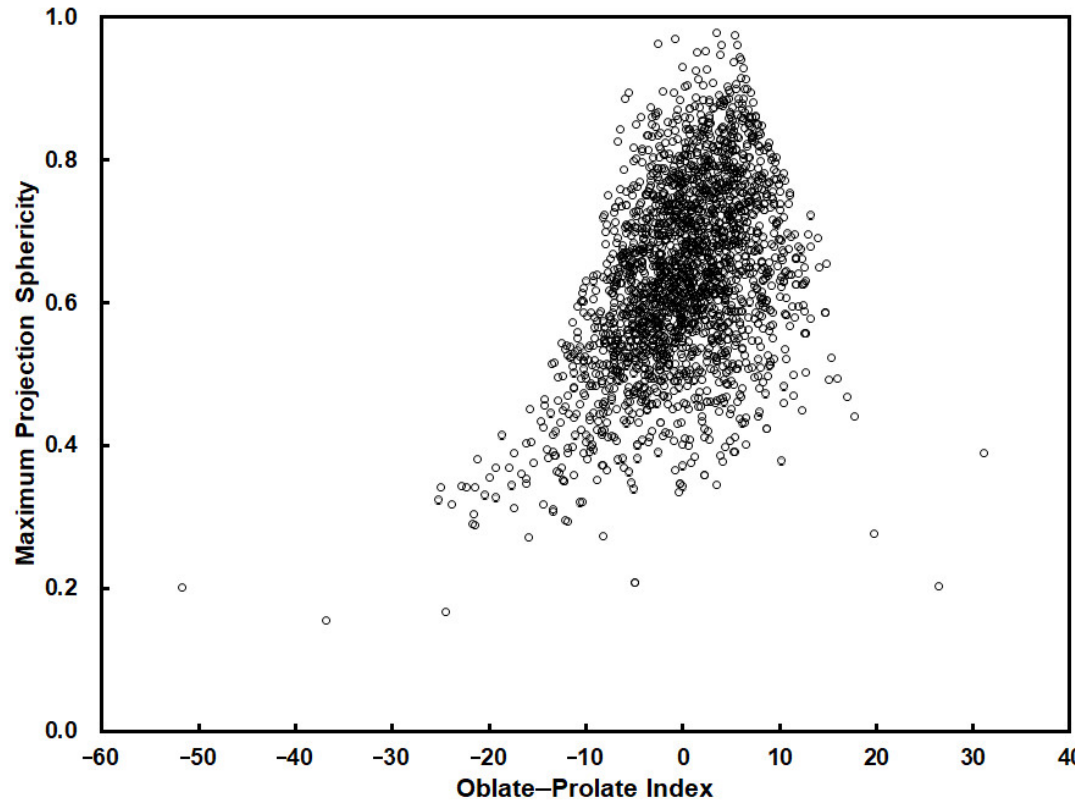
Figure 21. The Oblate–Prolate Index and Maximum Projection Sphericity of 3171 gravels from fluvial, beach, tsunami and weathering environments. Source of data: Gale [95], Jones and Hunter [96], Bryant and Haslett [97], Kennedy et al. [98] and unpublished measurements.